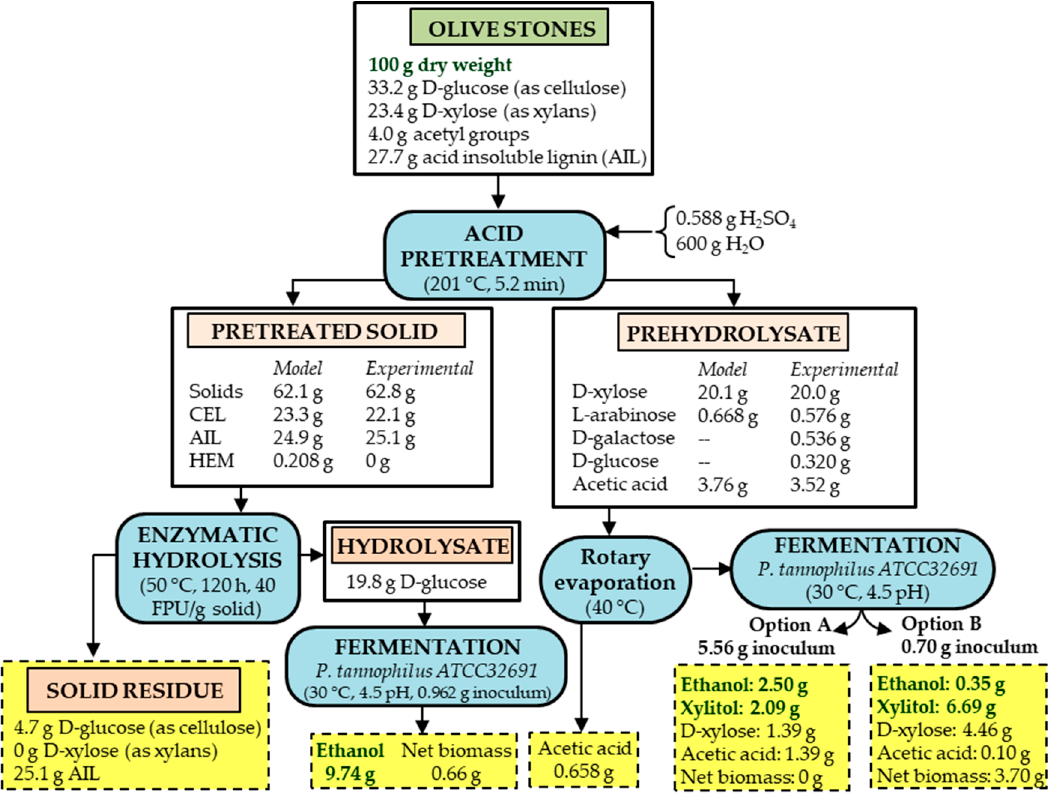
Figure 10. Mass macroscopic balance for the ethanol production flowsheet composed of dilute-acid pre-treatment of OS, enzymatic hydrolysis of pre-treated solids, detoxification with rotary evaporator and fermentation of hydrolysates using P. tannophilus . Reproduced with permission from Cuevas et al., Processes; published by MDPI, 2020 [23].